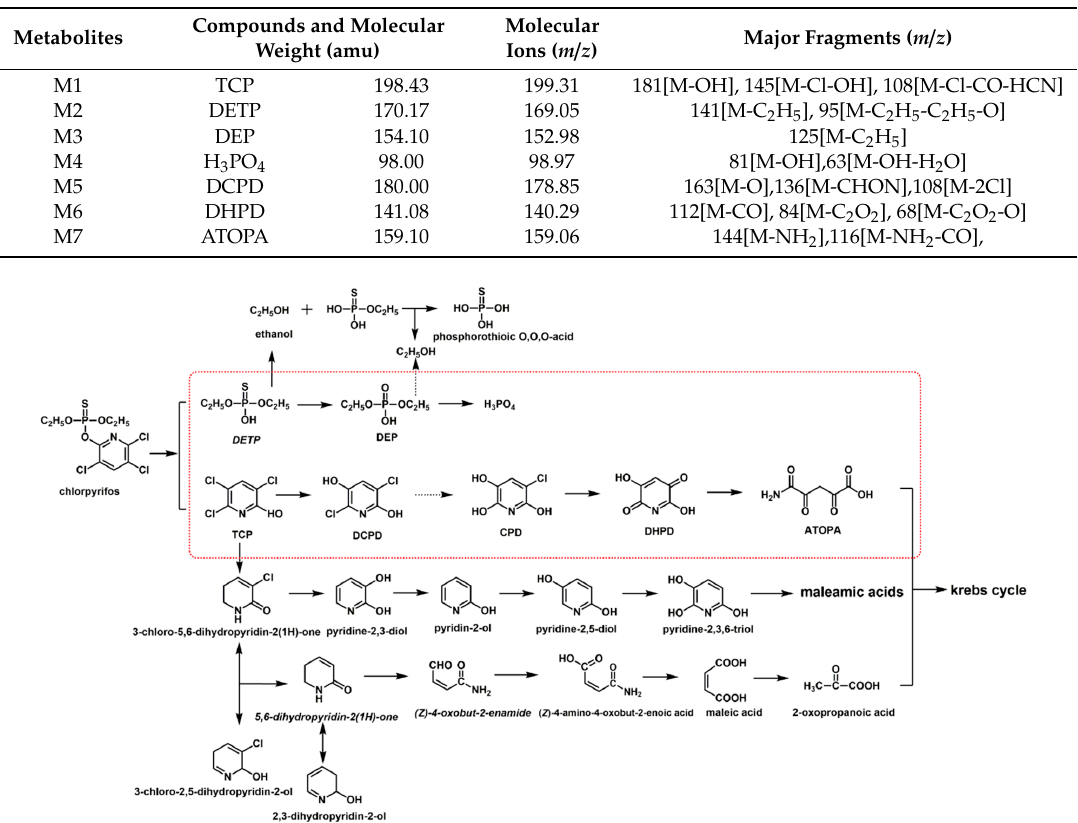
Figure 5. Degradation pathways of chlorpyrifos in strain X1 T and other bacteria. The degradation pathway of strain X1 T is shown in the red